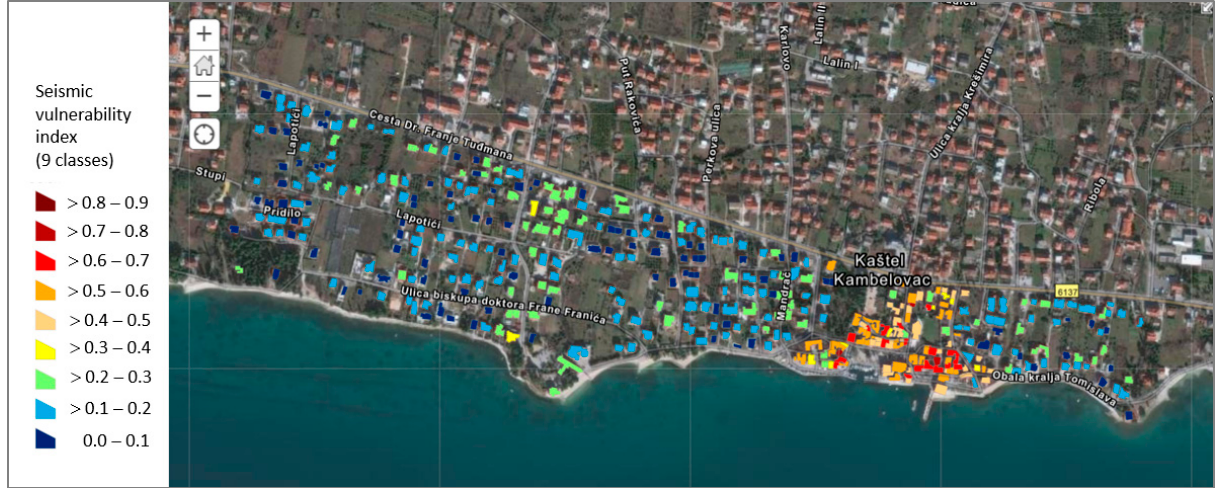
Figure 5. Seismic vulnerability index of buildings divided into 10% intervals.